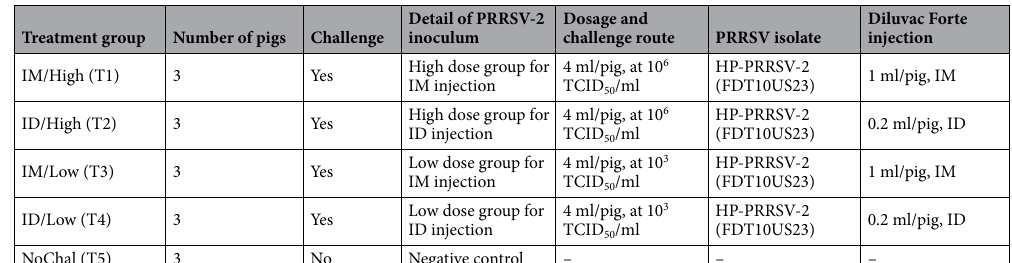
Table 2. Experimental design of experiment B (Exp B). Five treatment groups included 4 challenged groups and 1 non-challenged group. Pigs were intranasally inoculated with HP-PRRSV-2 at 0 days post-challenge (DPC). Pigs in non-challenge (NoChal) served as the control. At 7 DPC, the challenged pigs were injected with Diluvac Forte via either IM or ID routes with the same needle or needle-less device used for inoculating pigs. ID injection was performed using an IDAL 3G needle-free